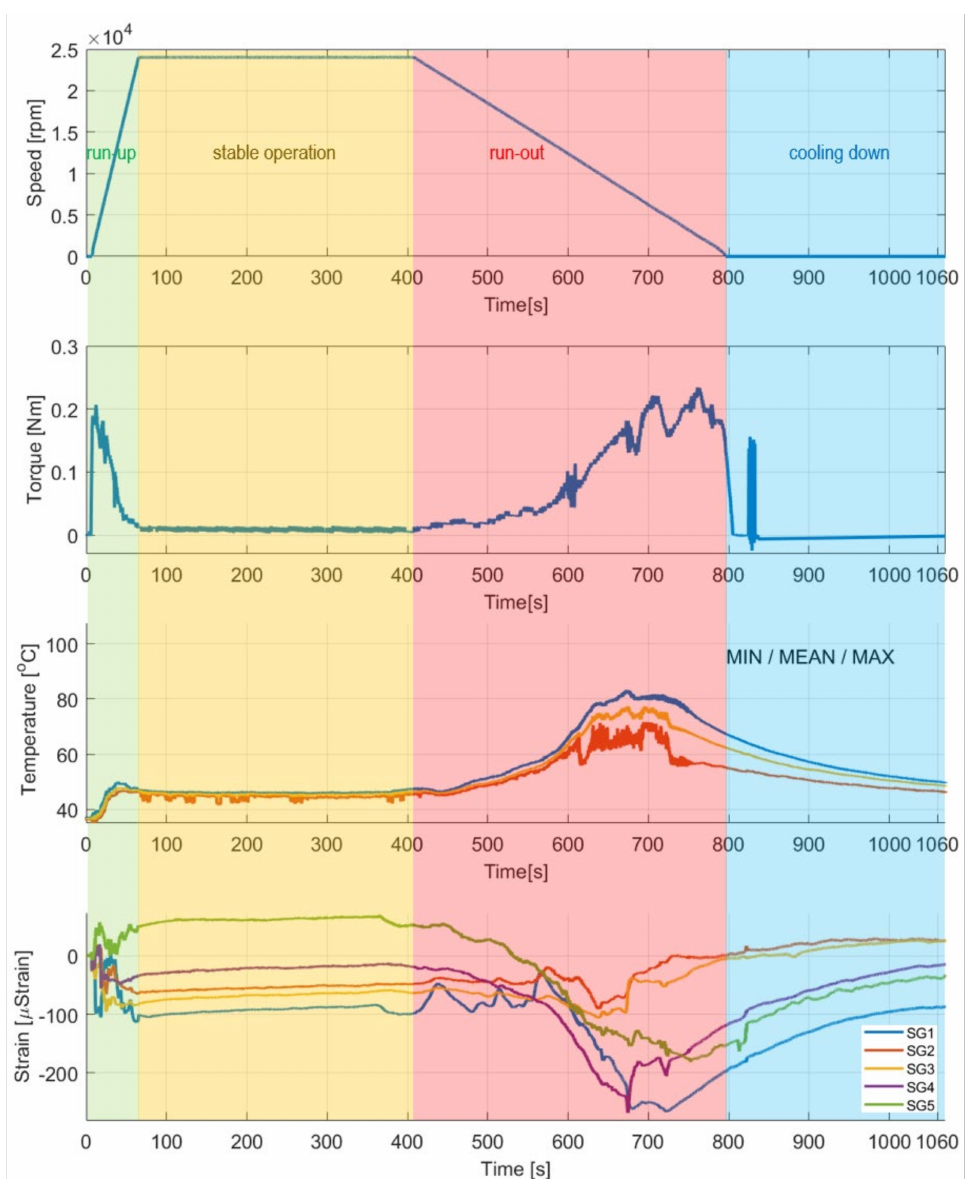
Figure 10. Temporal courses for the investigated operational characteristics of the GFB’s prototype. From the top down to bottom: rotational speed of the shaft’s journal, friction torque, temperature, and strain for the circumferentially distributed measurement points in the sensing top foil. Localization of the strain gauges SG1 up to SG5 is provided in Table